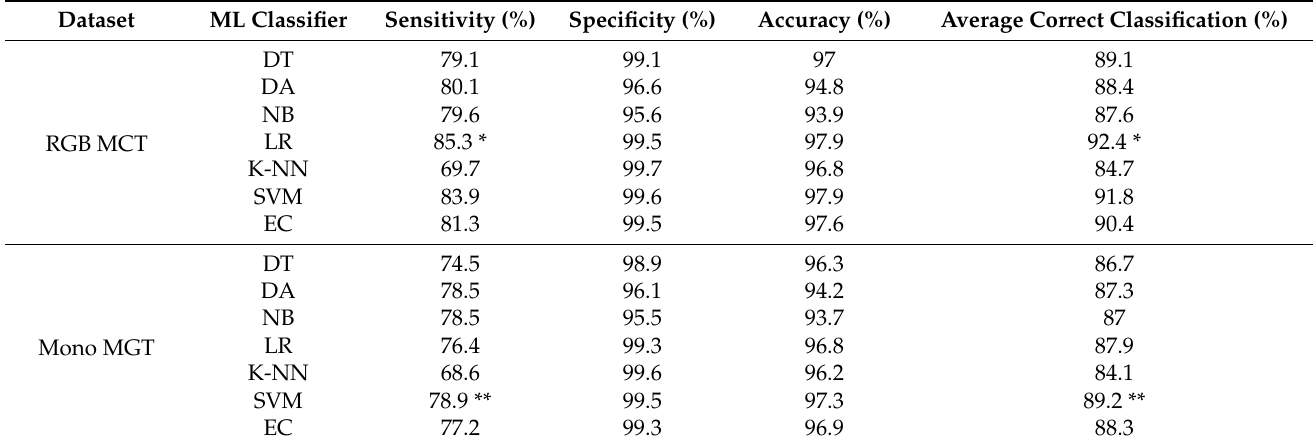
Table 6. The classification performance of the combined parameters of the RGB and Monochrome image datasets for the morphology, greyscale and texture